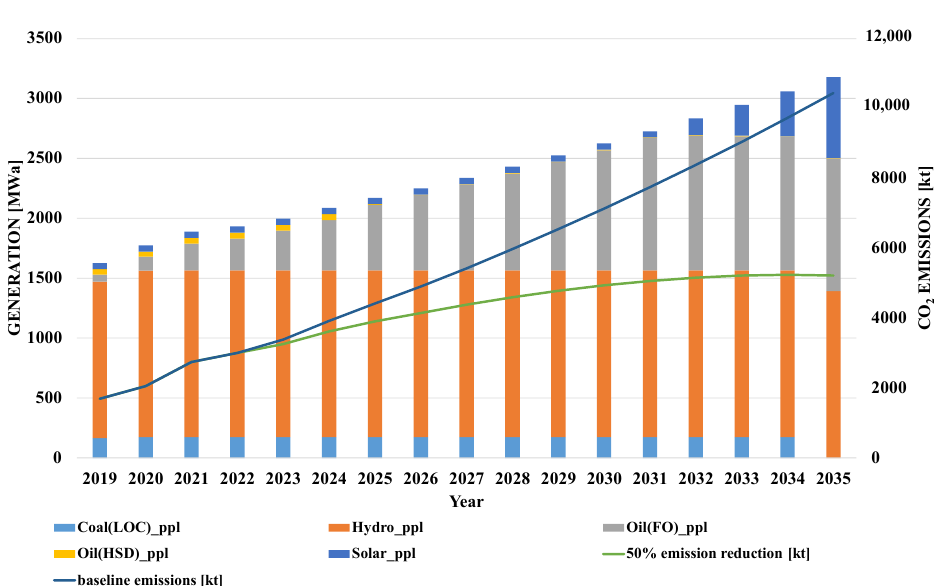
Figure 16. Generation mix and resulting CO 2 emissions for 50% reduction of emissions